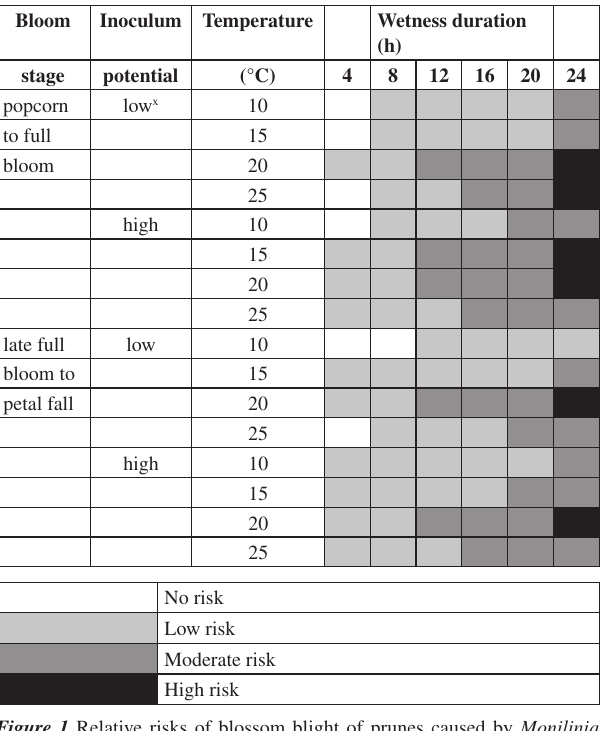
Figure 1 Relative risks of blossom blight of prunes caused by Monilinia fructicola in relation to different bloom stages, inoculum potentials, temperatures, and wetness durations (adapted from Luo et al., 2001b)